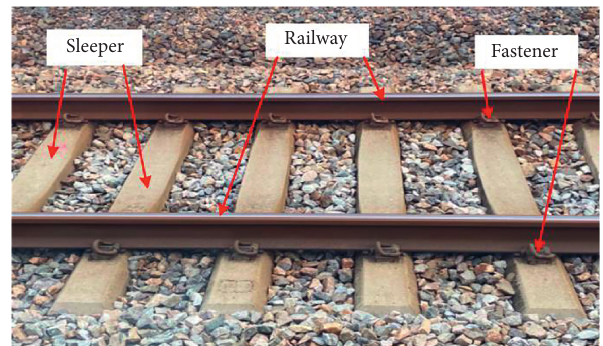
Figure 1: Railway track